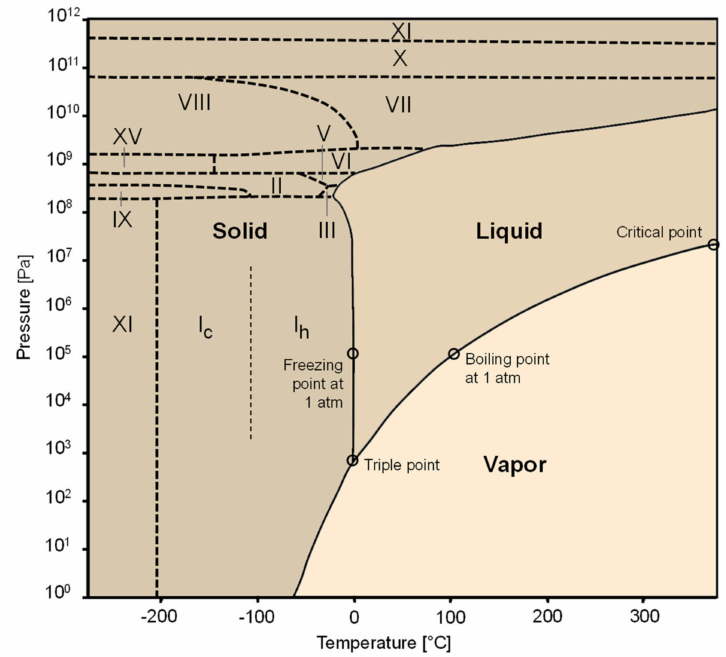
Figure 2. Phase diagram of water as a function of temperature and